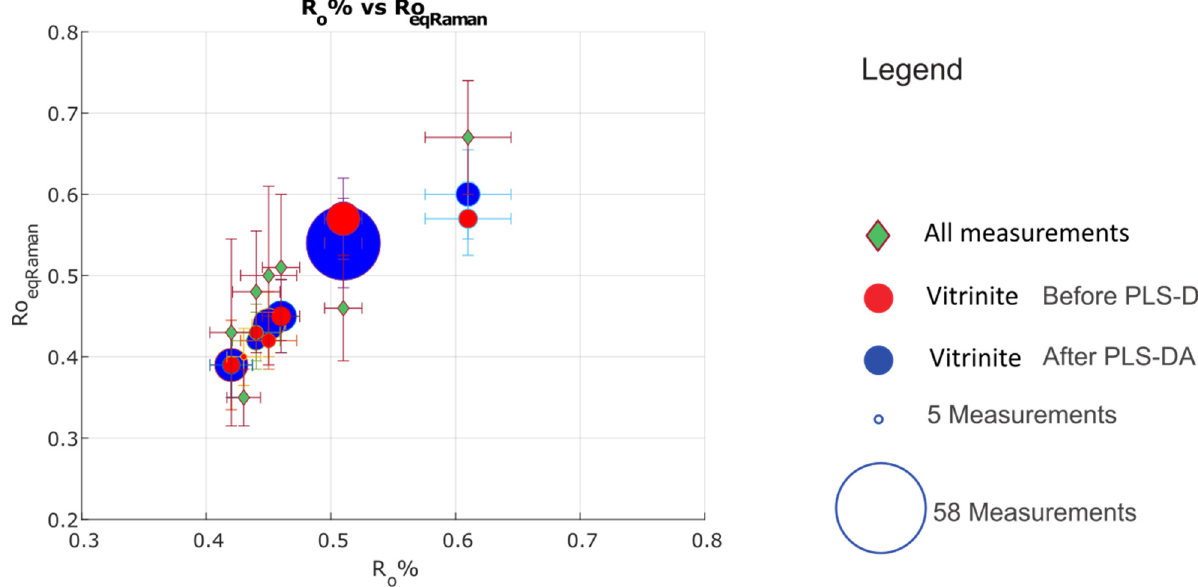
Figure 8. The diagram shows the correlation between the microscopic determination of vitrinite reflectance (R o %) and the reflectance equivalent of vitrinite (R oeq %) macerals calculated by means of Raman parameters, according to [38], for values obtained before (red circles) and after (blue circles) PLS-DA analysis. The size of the circles depends on the number of measurements for each sample. Green diamonds show R oeq % values calculated on all macerals composition .